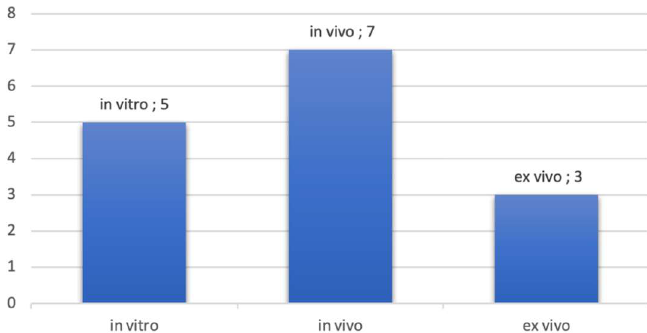
Figure 3. Number of publications by type of exploration.